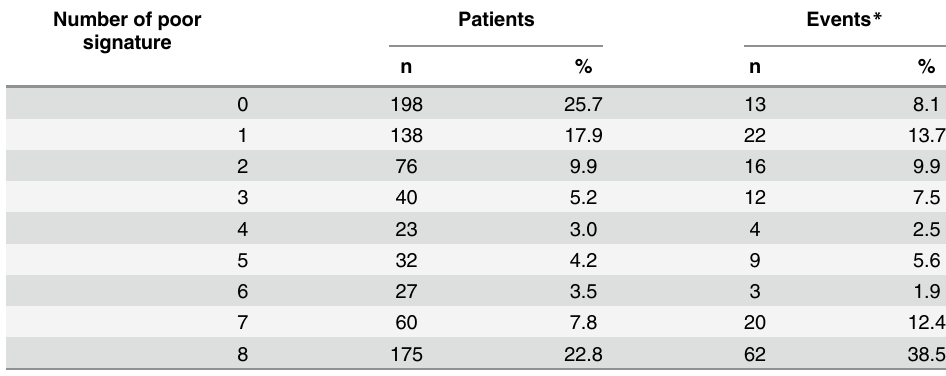
Table 3. Repartition of patients according to number of poor